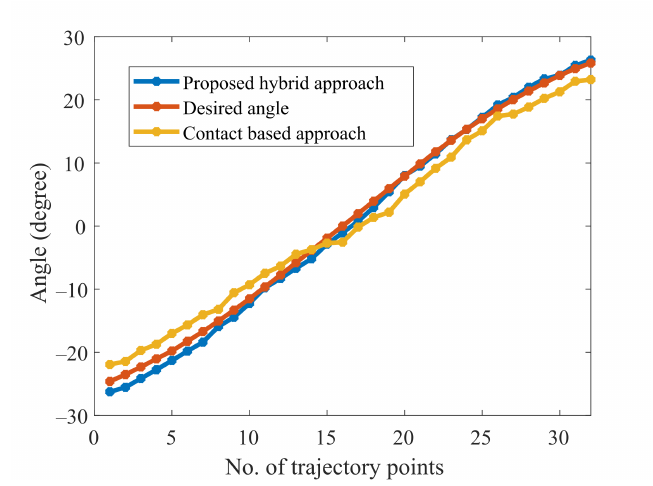
Figure 15. Comparison between contact-based and proposed approaches.